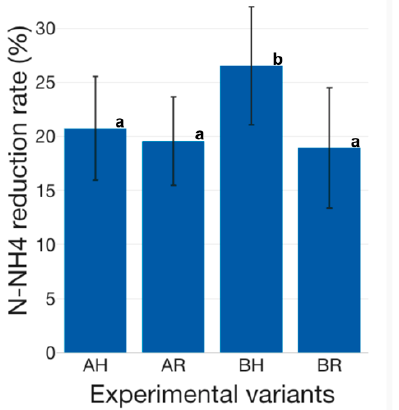
Figure 25. The N-NH 4 reduction rate and standard error (SE) for each of the experimental variants (Tukey test)—different letters reveal significant statistical differences ( p < 0.05), whereas the same letter reveal not significant statistical differences ( p > 0.05).